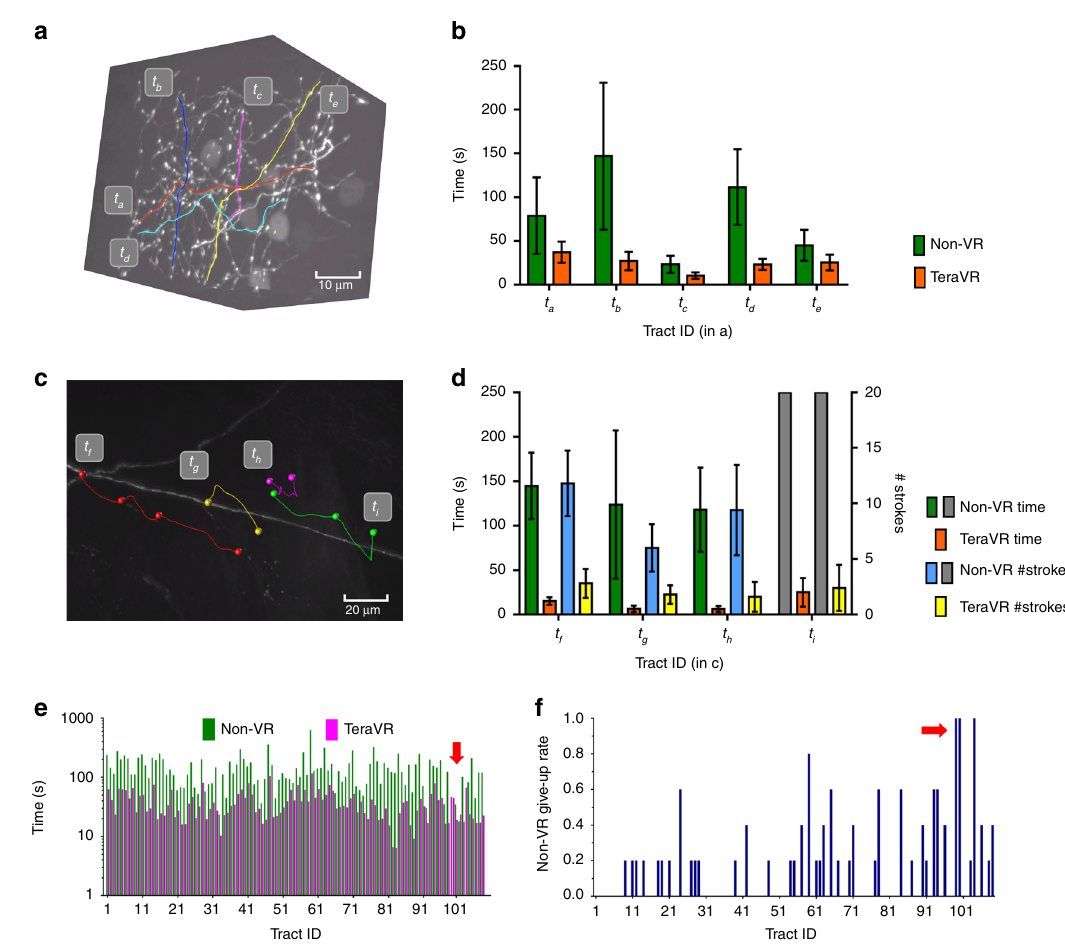
Fig. 2 Ef fi ciency of TeraVR. a A complex three-dimensional (3-D) image volume with a number of intermingled, broken, strongly punctuated axon tracts t t fi ve tracts in a , each of which was produced by fi ve independent annotators; the “ non-virtual reality (VR) ” results a ~ e . b Time spent to generate the showed were obtained using TeraFly (same below in this fi gure); error bar: SD. c A 3-D image volume with weak signal and strong noise, and the respective TeraVR reconstructions of barely visible neurite tracts t f ~ t i . d Time and the number of operations needed to produce the tracts in c . Gray bar: unavailable results (time/number of strokes) for non-VR approach. e Average time of 5 annotators to generate 109 tracts, which were hard to reconstruct. For non-VR, the average was calculated among the sub-group of annotators who succeeded in reconstructing the tract. f The give-up rate of non-VR for each tract in e ; an annotator was allowed to give up the attempt after trying 300 s; the give-up rate for each tract was de fi ned as (#failed attempts)/(#all attempts). Arrows in e , f : the cases where no non-VR attempt was able to produce the respective neurite